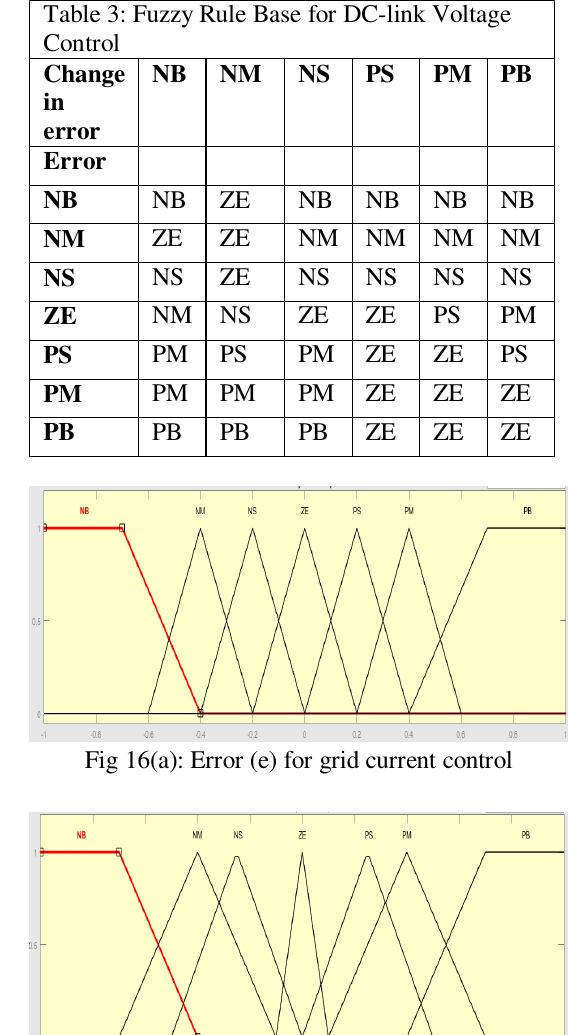
Fig 16(b): Change in Error ( Δ e) for grid current